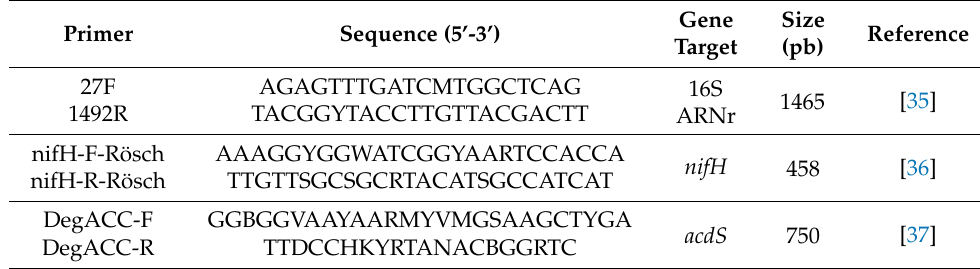
Table 1. Primers used in this